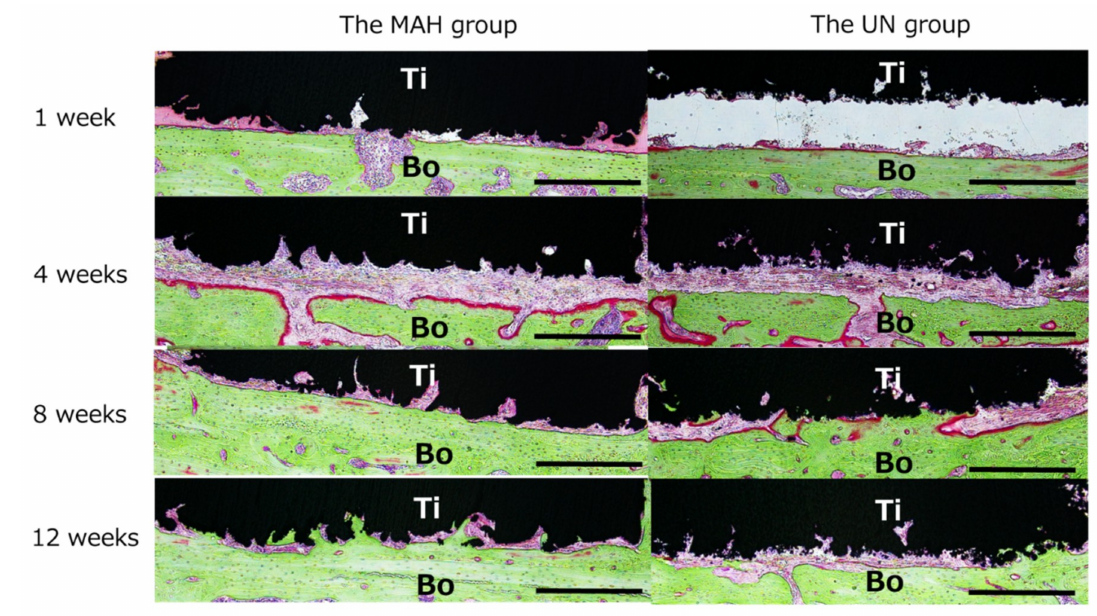
Figure 7. Histological observation. Active bone formation between the calvarial bone and the Ti surface is seen in the MAH group. The scale bar indicates 500 µ m. Ti: Titanium plate, Bo: Calvarial